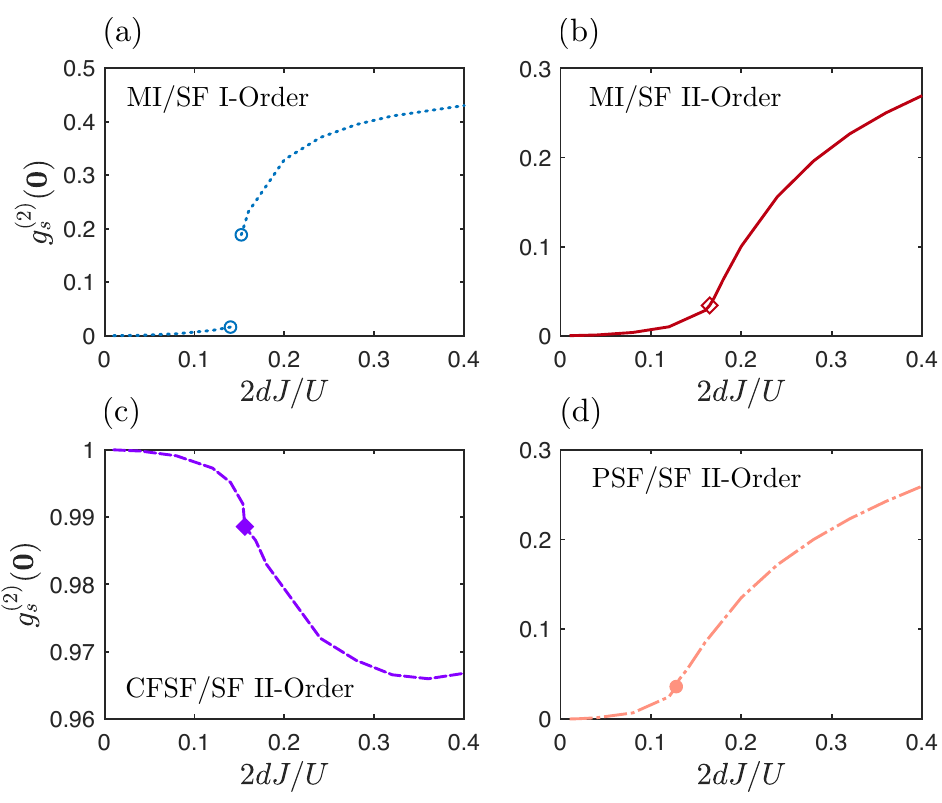
Figure 16: Local spin-spin correlation g ( 2 ) of 2 d J / U across the same phase transitions as in Fig.